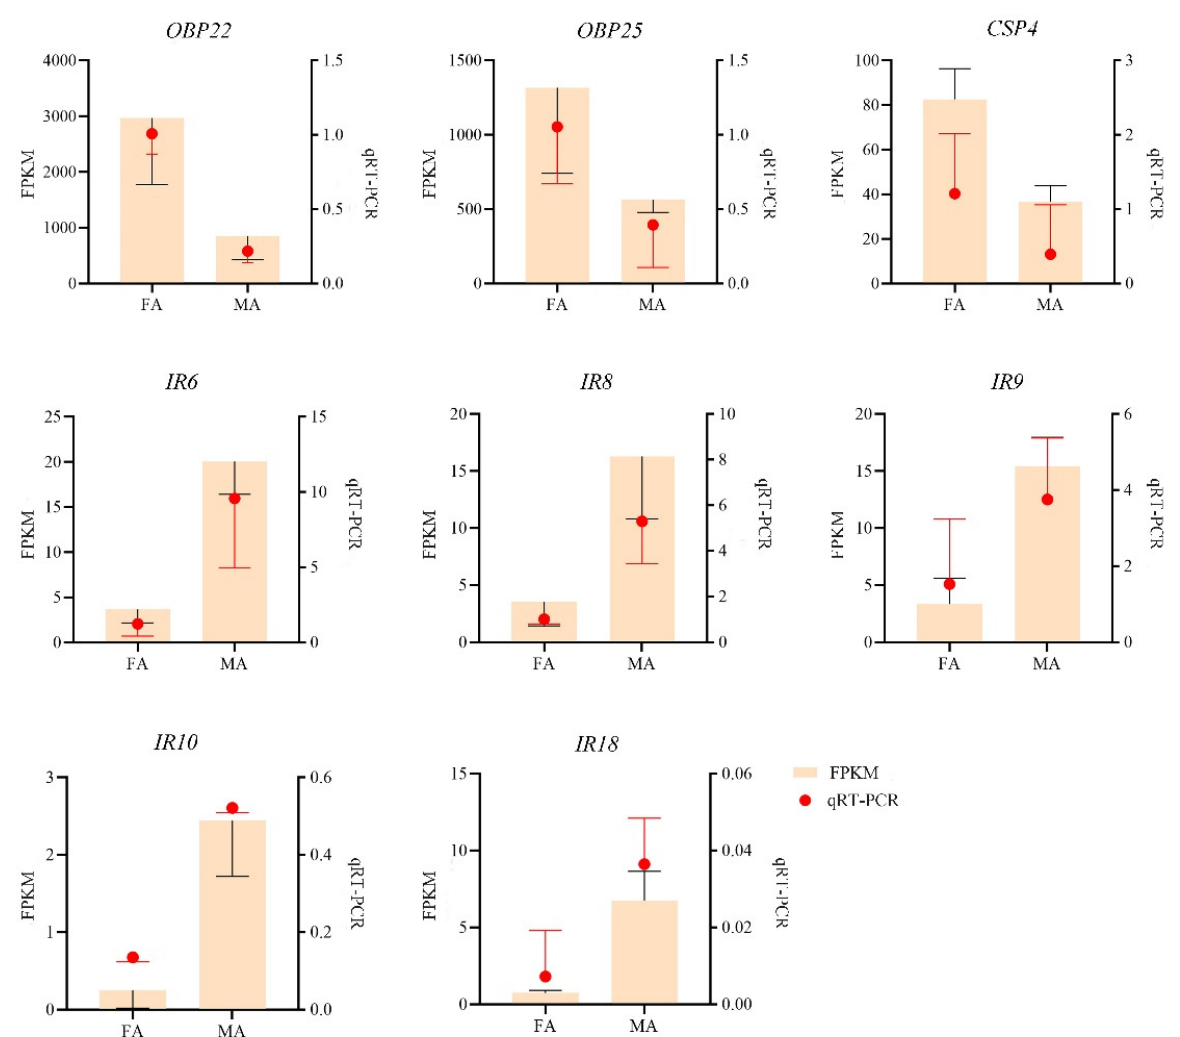
Figure 4. Validation of gene expression by qRT-PCR of selected genes. These genes included OBP22 , OBP25 , CSP4 , IR6 , IR8 , IR9 , IR10 , and IR18 of Glenea cantor . Orange bars indicate the FPKM values ( y -axis on left) and the red dots represent the relative expression level ( y -axis on right). FA: female antennae; MA: male antennae. Data were shown as mean ± SD ( n =3).